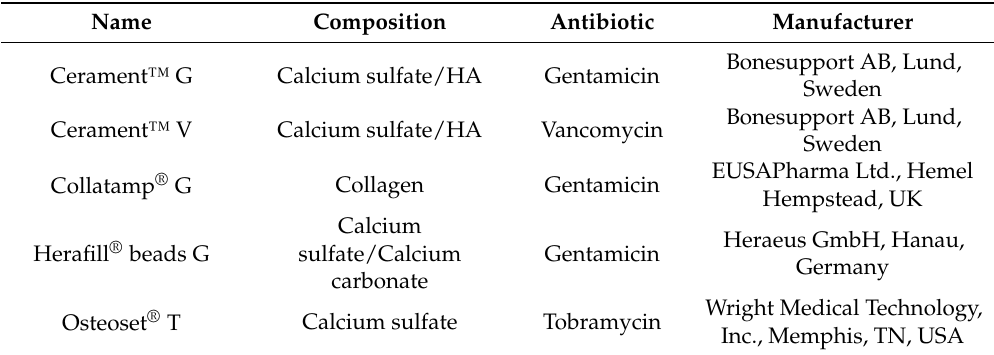
Table 2. Antibiotic-loaded biomaterials (CE